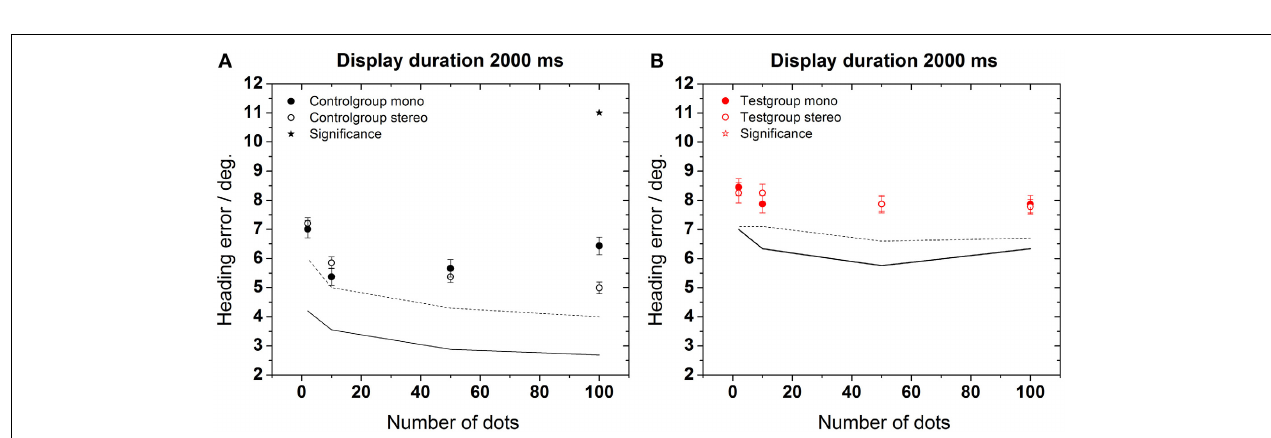
FIGURE 8 | Influence of non-coherent motion on translational heading. The left panel (A) shows data from the control group for non-coherent motion with stereoscopic stimulation (open symbols) and without (filled symbols). Data from the test group are shown in an analog manner in the right panel (B) . Performance with and without stereoscopic stimulation was significantly different only in the control